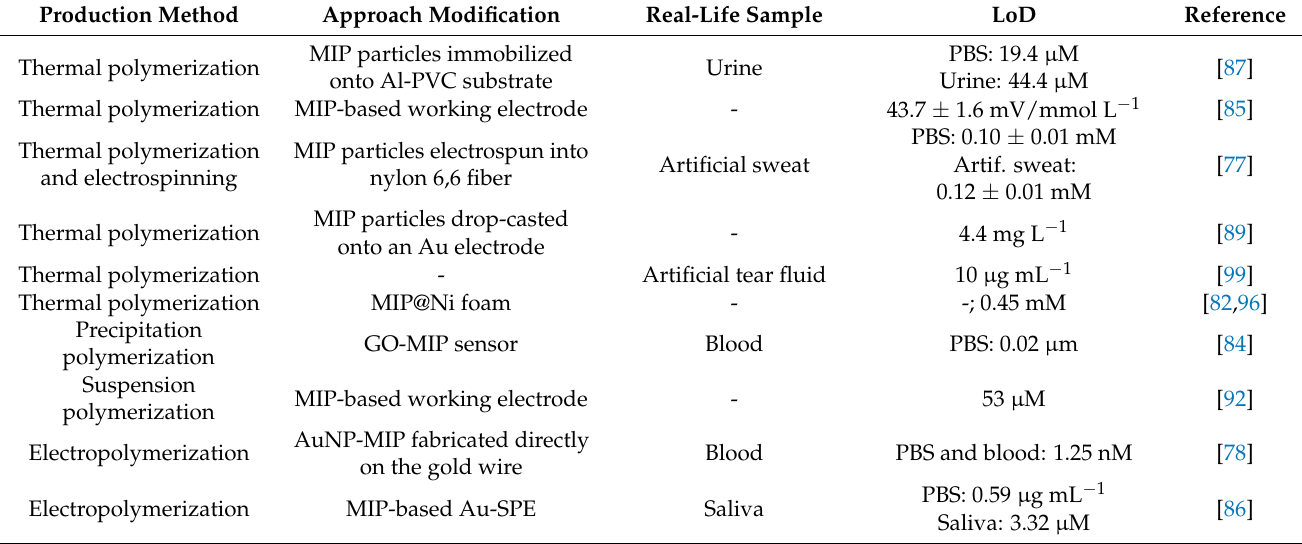
Table 1. Fabrication methods and modifications employed for the production of MIP-based sensing materials for glucose